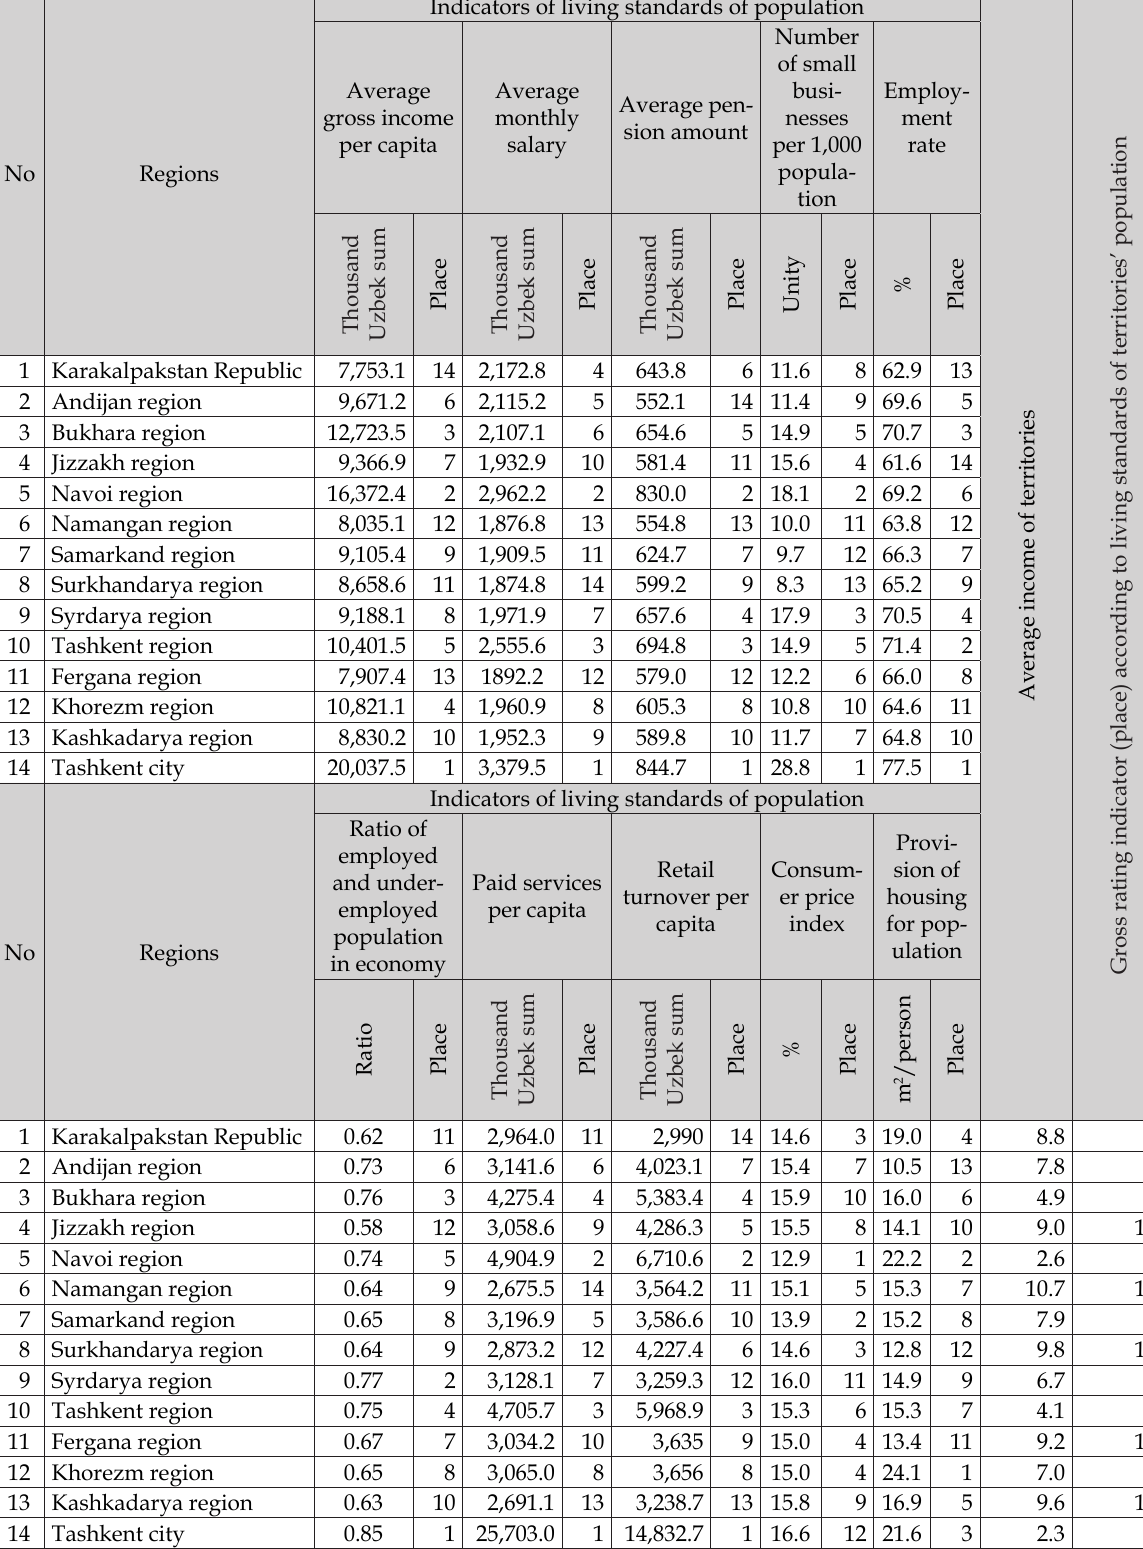
Table 1. Assessment of the rating of the regions of Uzbekistan by a set of socio-economic indicators with re- spect to living standards